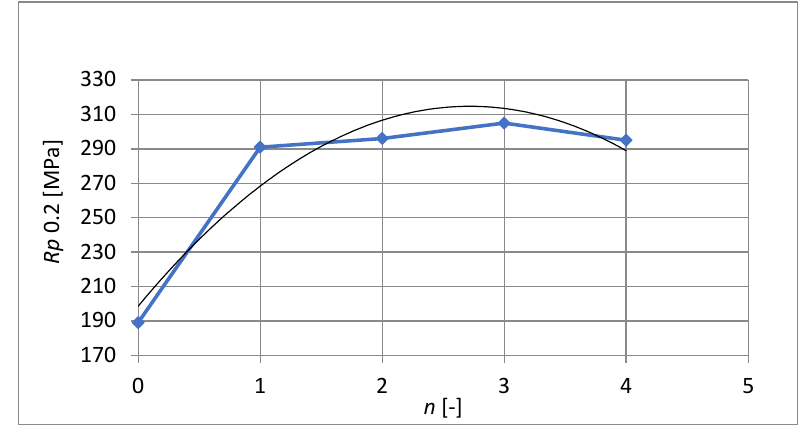
Figure 11. Yield point after individual extrusions. Figure 12. The course of the ultimate tensile strength after individual extrusions.